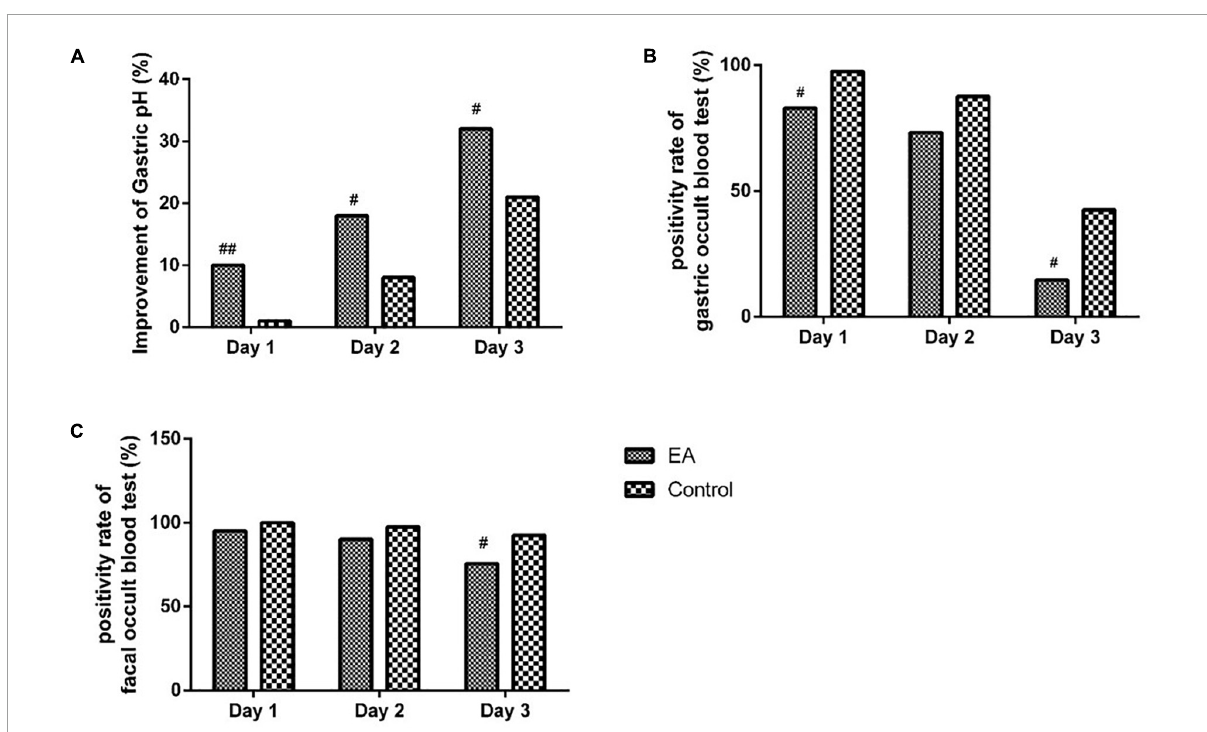
FIGURE2 Comparison of gastric pH, occult gastric blood, and fecal occult blood test within 3 days after operation between the two groups. (A) Comparison of gastric pH within 3 days after operation between the EA and control groups. (B) Comparison of gastric occult blood test within 3 days after operation between the EA and control groups. (C) Comparison of fecal occult blood test within 3 days after operation between the EA and control groups. Day 1 = 1 day after operation; day 2 = 2 days after operation; day 3 = 3 days after operation. # P < 0.05, ## P <